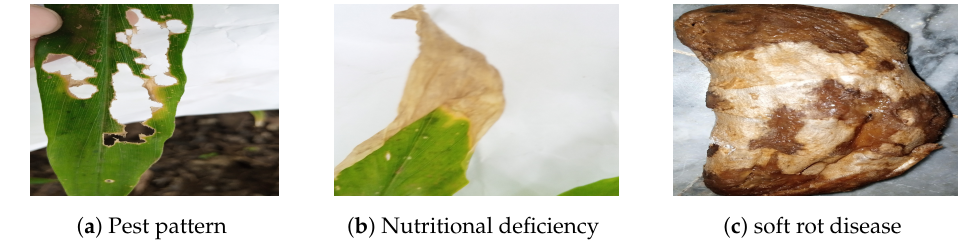
Figure 3. Output images after applying data augmentation and